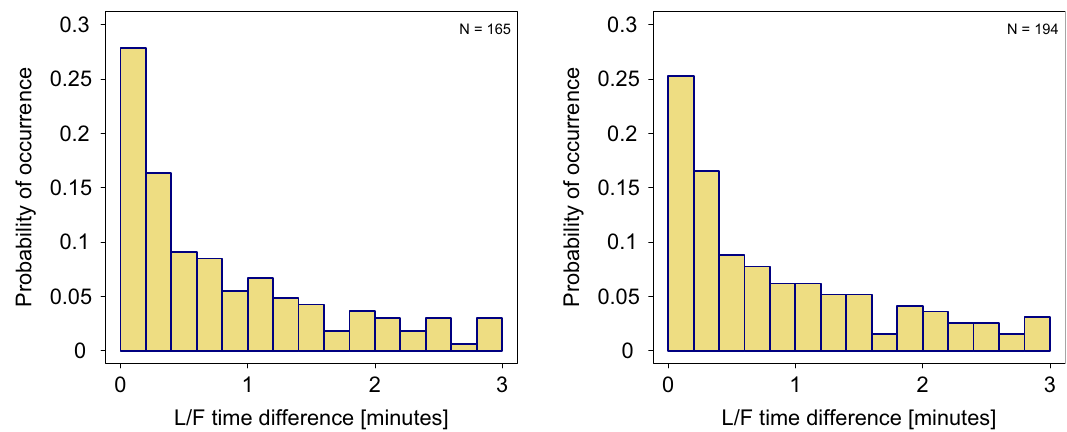
Figure 1. L/F time differences for the GB2 colony in 2008. Histograms show the absolute differences between the times at which the leader and the follower were recorded in all identified L/F events. Parameters: turnaround_time = lf_delay = 3 min (both plots), occupation_deadline = 2 a.m. (left) and occupation_deadline = 3 a.m. (right). Insets indicates the total number of identified L/F events.